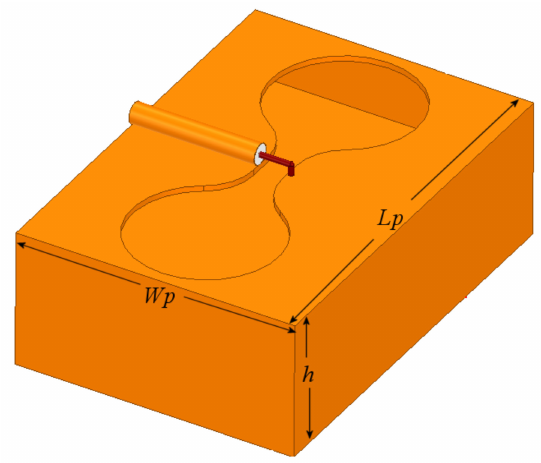
Figure 5. Dumbbell-shaped slot radiator with box reflector.